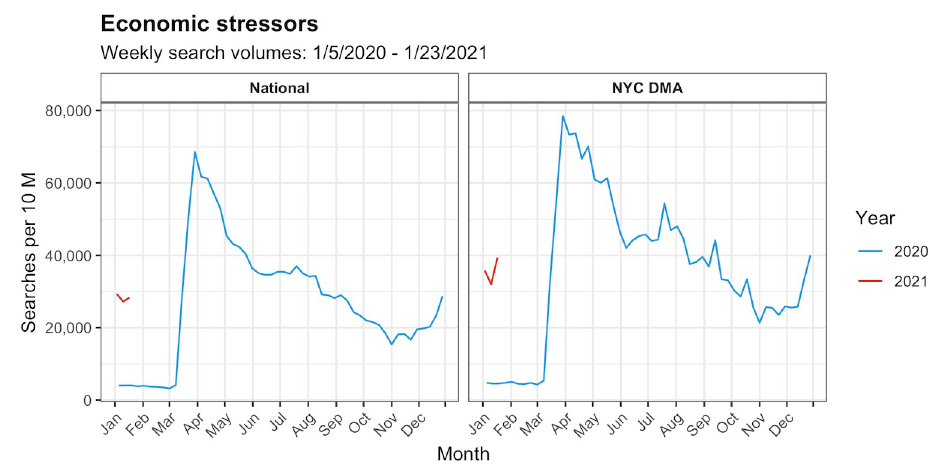
Fig 2. Google Health Trends search volumes for economic stressor terms over time nationally and in the NYC DMA: 2020–2021.